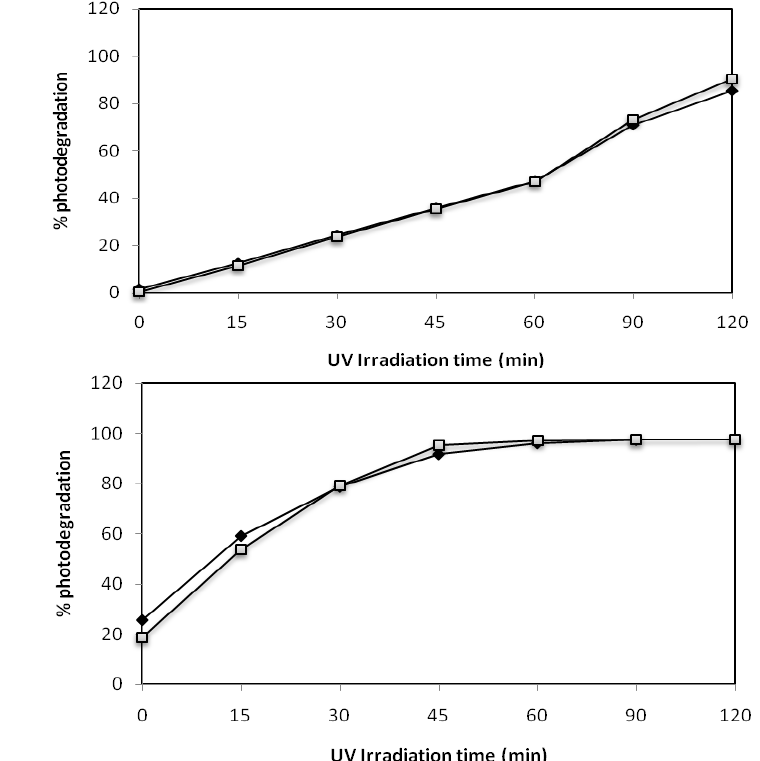
Figure 11. Effect of UV-Irradiation time on the degradation of a 30 mg·L − 1 mixture of the azo dyes C.I. Reactive Red 239 ( ) and C.I Reactive Black 5 ( ) with (a) 0.1 g·L −